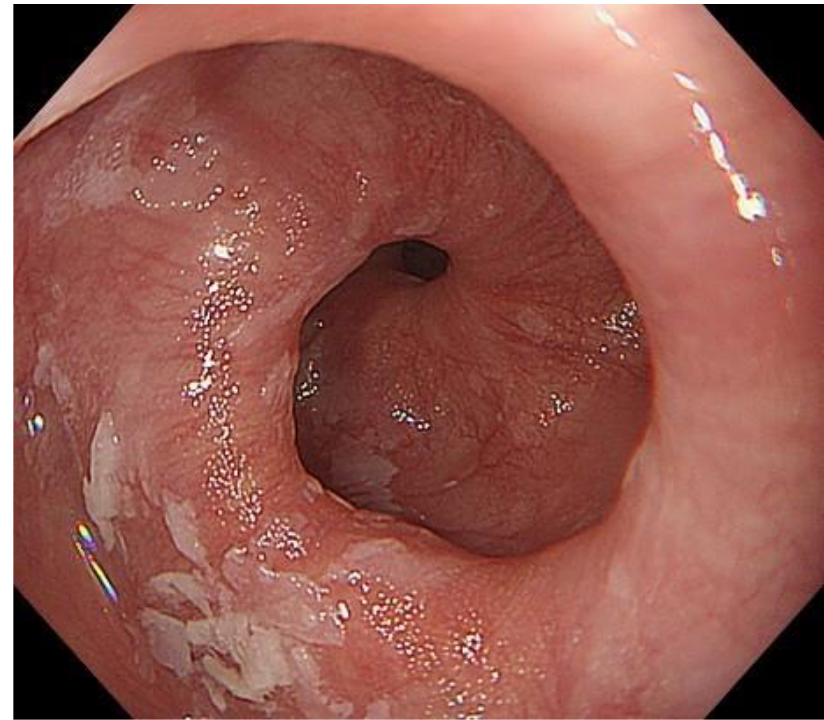
Figure 6. A case with hypercontractile esophagus in which corkscrew esophagus was observed. Evaluation of weak contractions in the esophageal body is challenging. The esopha- geal lumen is occluded during esophageal peristalsis in subjects with normal esophageal motility. It has been reported that non-occlusive contraction could indicate weak peristal- sis